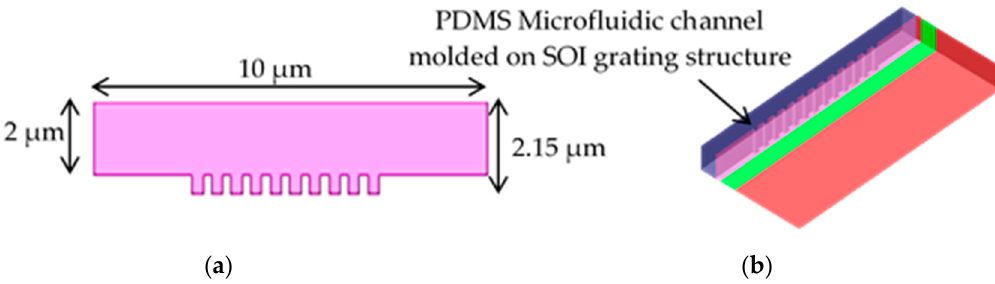
Figure 4. ( a ) The structure (two-dimensional view) of the PDMS microfluidic channel and ( b ) the SOI grating coupler with the PDMS microfluidic channel .